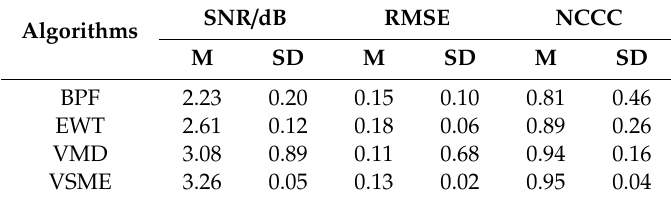
Table 2. Mean and standard deviation (SD) of the three indexes used for comparing di ff erent algorithms. Algorithms